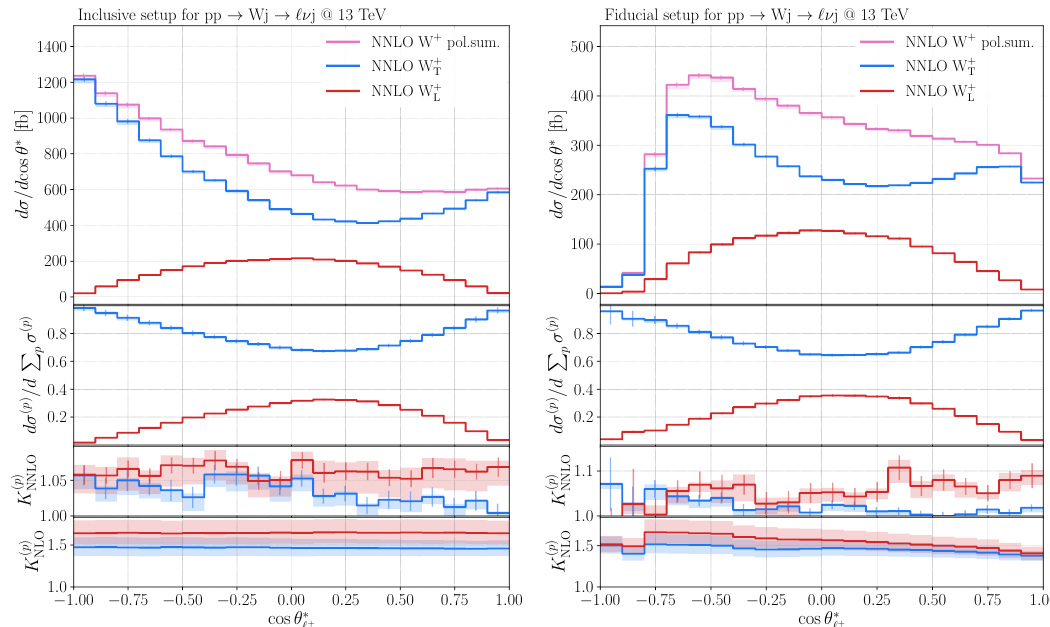
in the inclusive (left) and fiducial (right) setup for Figure 2 . Differential distributions for cos θ ∗ ‘ + pp → ‘ + ν j process. In the upper pane, the transverse and longitudinal polarised predictions as ‘ well as their sum are displayed at NNLO QCD accuracy. In the middle pane, the transverse and longitudinal polarised predictions are normalised to the sum of the two. The lower pane shows the respective K -factors (NLO and NNLO) for the various polarised predictions. The bands represent the 7-point scale variation while the bars indicate the Monte Carlo uncertainty.